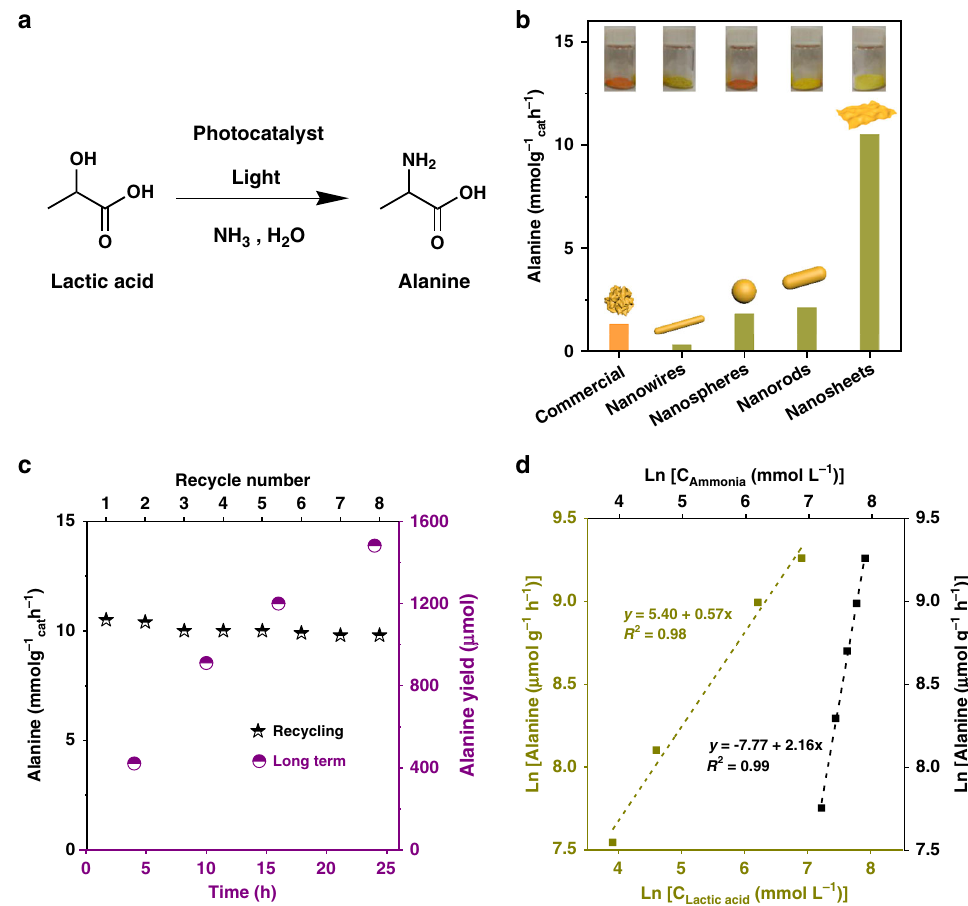
Fig. 2 Photocatalytic synthesis of alanine from biomass-derived lactic acid. a Scheme for amination of lactic acid to alanine with ammonia. b Alanine production rate over CdS catalysts with different types of morphology under visible light. c Recycling study and stability over CdS nanosheets. Reaction conditions: 10 mg photocatalyst, 20 mmol lactic acid, 4 mL ammonia solution (25 wt%), 16 mL deaerated water, T = 50 °C, and 1 bar N 2 . For recycle experiments, t = 4 h. The black star in c denotes recycling activity. The purple cycle in c denotes long-term activity. d Logarithm of rates versus logarithm of lactic acid and ammonia concentrations. Reaction conditions: 10 mg nanosheets, 20 mL solution (lactic acid + ammonia + H 2 O), T = 50 o C, 1 bar N 2 , visible light, and t = 4 h. The yellow dot line and square in d denote lactic acid. The black dot line and square in d denote